Question: Describe this figure in one sentence.
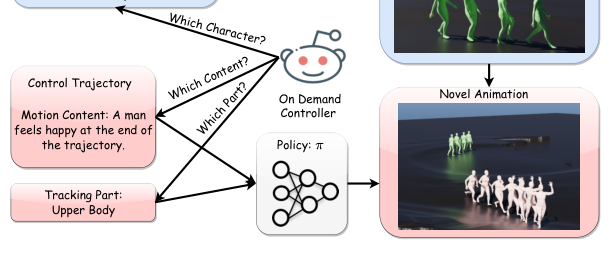
Answer: Our framework presents an on-demand control system tailored for real-world videos. Beginning with the pre-processing in [62], our policy network can track high-confidence motions and effectively fill in missing parts without additional fine-tuning. Moreover, our framework offers the novel functionality of intro- ducing customized animations into real-world scenarios with flex- ible control options.